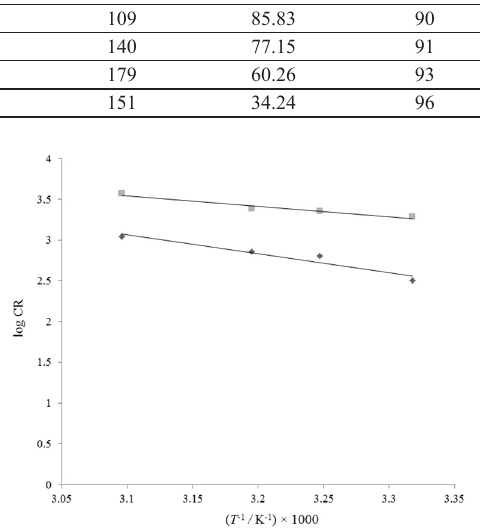
Figure 5. Typical Arrhenius plots for corrosion of mild steel in 1 M HCl solutions in the absence (■) and presence (♦) of inhibitor (200 mg/L) at various